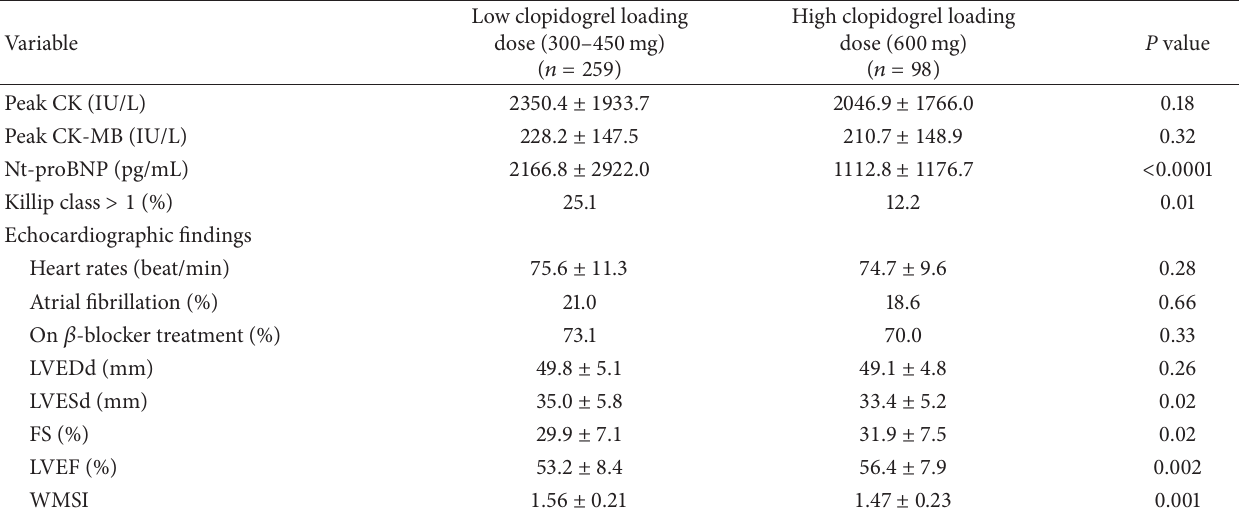
Table 4: Heart function related indices.